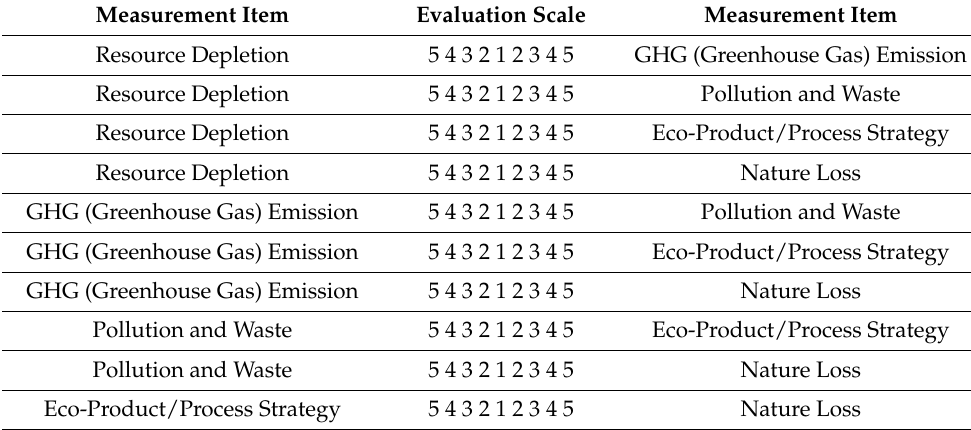
Table A6. Environmental factor question